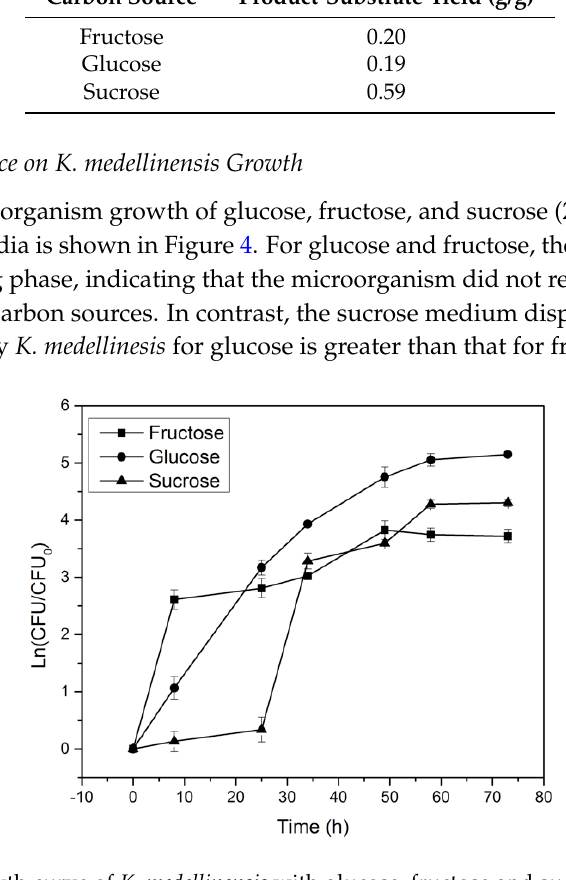
Figure 4. Growth curve of K. medellinensis with glucose, fructose and sucrose at 2% w / v .